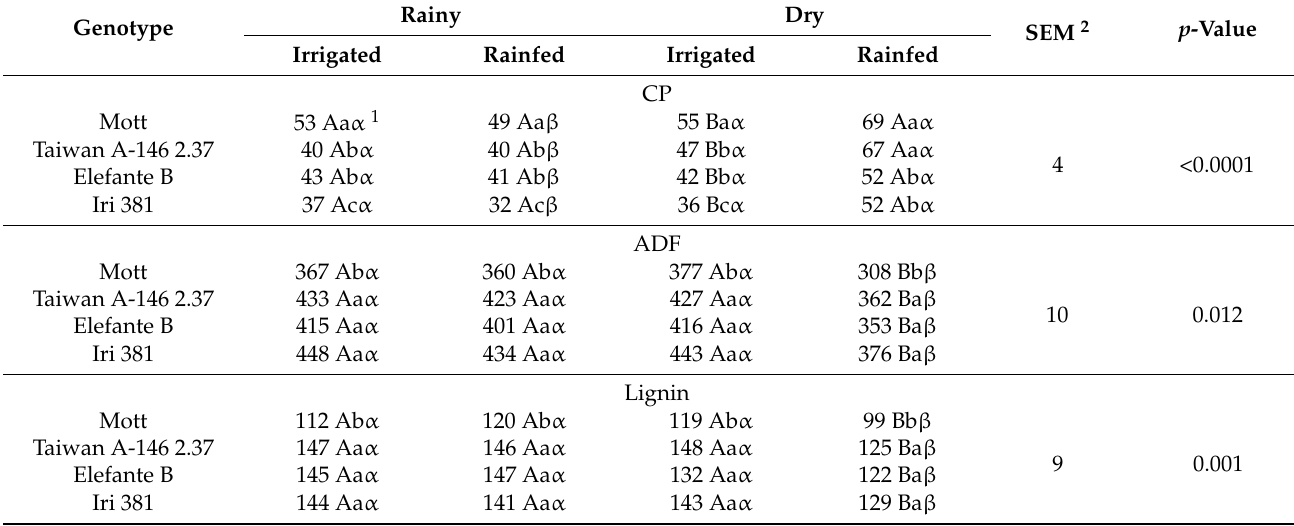
Table 6. Stem crude protein (CP), acid detergent fiber (ADF), and lignin concentration ( g/kg dry matter ), as affected by the interaction between irrigation, genotype, and season for elephantgrass genotypes at Garanhuns, Pernambuco, Brazil. Genotype